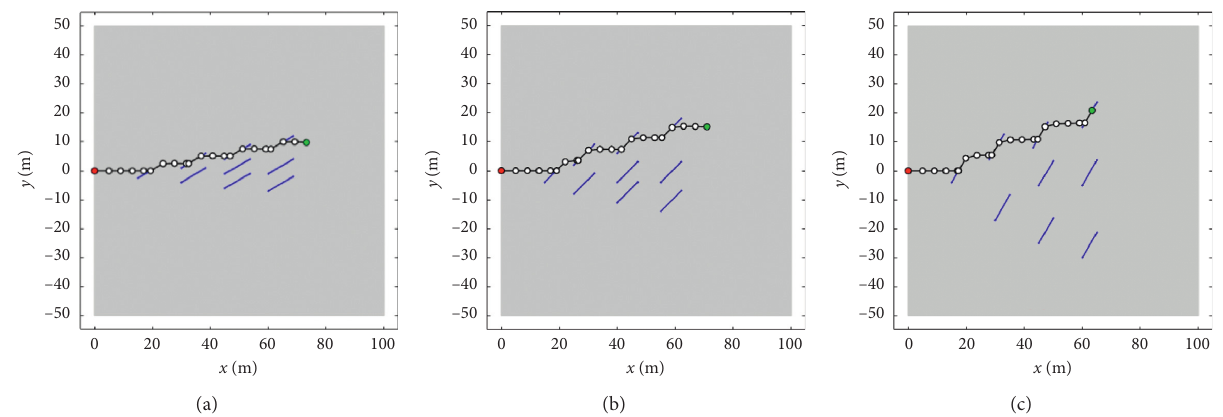
Figure 7: Fracture propagation morphology under Blanton’s criterion. (a) Final fracture, 30 ° . (b) Final fracture, 45 ° . (c) Final fracture, 60 °